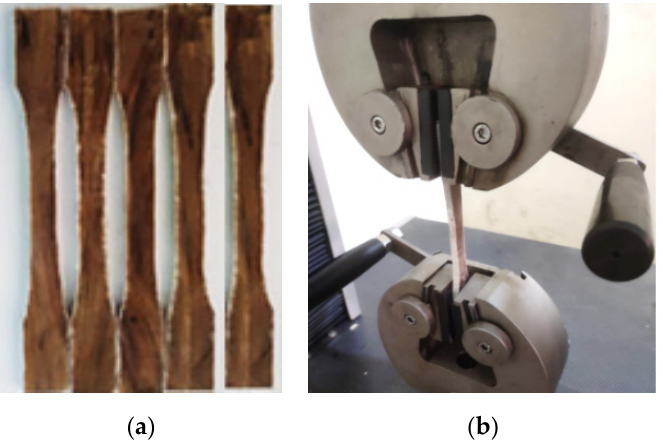
Figure 1. JFR composites specimens at 30% of weight ( a ) and testing of the JFR composite on tensile testing machine ( b ). Table 1. Longitudinal modulus from experimental studies.